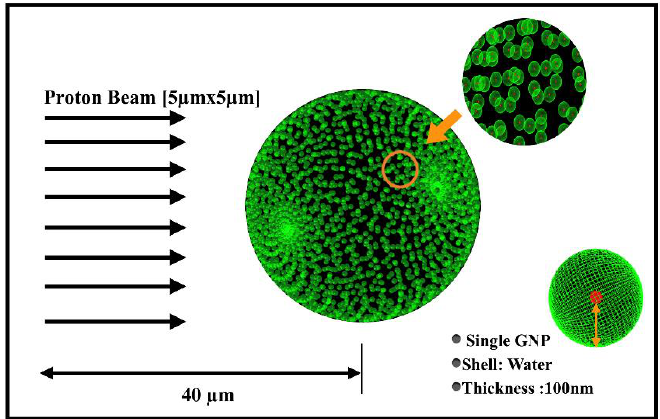
Figure 3. Visualization of 5 µm spherical tumor enveloped by randomly distributed GNP clusters, with 40 nm distance between surface source and central axis of tumor. with 40 nm distance between surface source and central axis of tumor.